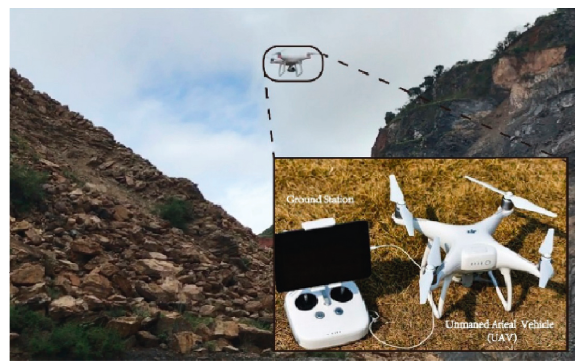
Figure 5: DJI Phantom 4 Pro and control system. Table 3: Yield calculation